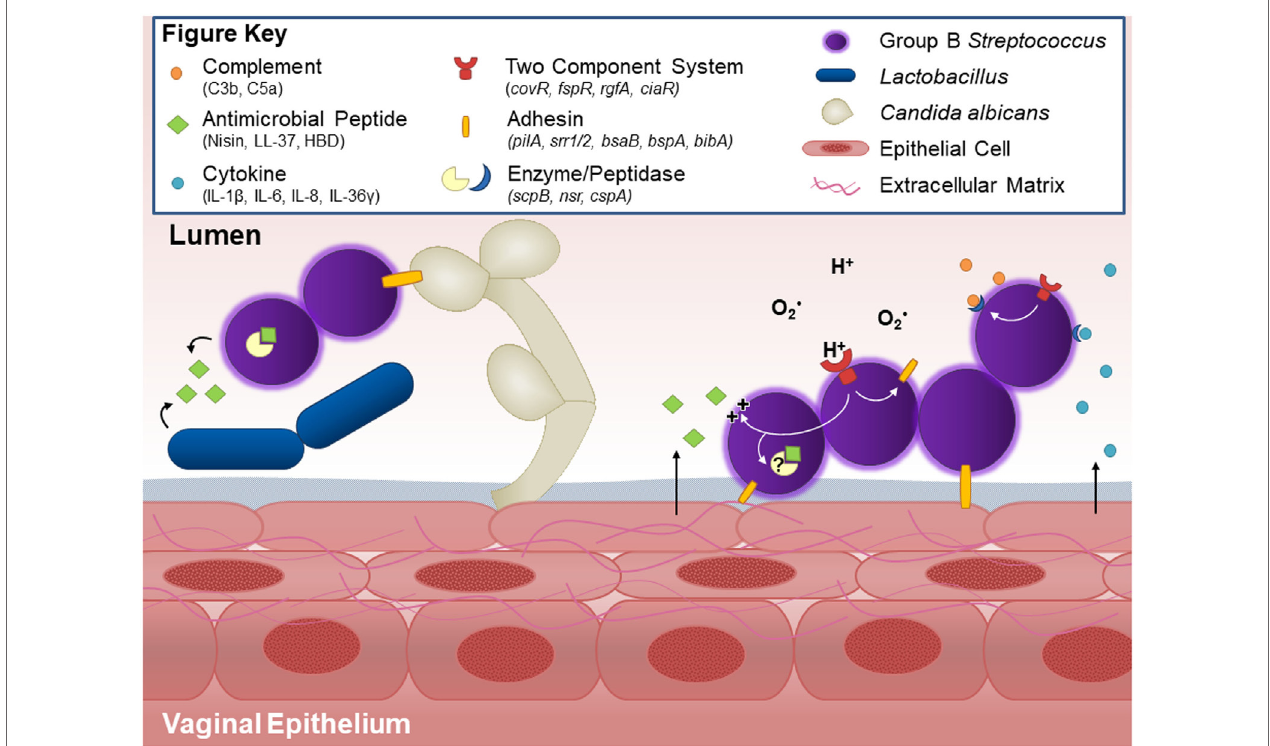
FiGURe 1 | Host and bacterial factors contributing to group B Streptococcus (GBS) vaginal colonization. Within the vaginal tract, GBS interacts with other vaginal flora. Lactobacillus and GBS both possess antagonistic activity against each other, likely through production of antimicrobial peptides and niche competition. GBS produces countermeasures such as the protease NSR, which degrades the lantibiotic Nisin produced by Lactococcus . Other flora, such as C. albicans , facilitate GBS vaginal colonization in part through the GBS adhesion BspA. GBS binds to host vaginal epithelial cells and extracellular matrix proteins through surface adhesins including pili, Srr-1 and Srr-2, BsaB, BspA, and BibA. Upon interaction with the epithelium, GBS elicits host cytokine responses such as IL-1 β , IL-8, CXCL1, and CXCL2, the latter two of which can be degraded by the serine protease CspA. The vaginal epithelium can also generate antimicrobial peptides, such as LL-37 or β -defensins, which GBS deflects with lipoteichoic acid-anchored d -alanine, or possibly degrades through yet unidentified peptidases. GBS further thwarts innate immune mechanisms by blocking capsular deposition of C3b or through degradation of C5a via ScpB. GBS uses multiple two-component systems to sense environmental conditions and regulate virulence and survival factors via response regulators such as CovR and